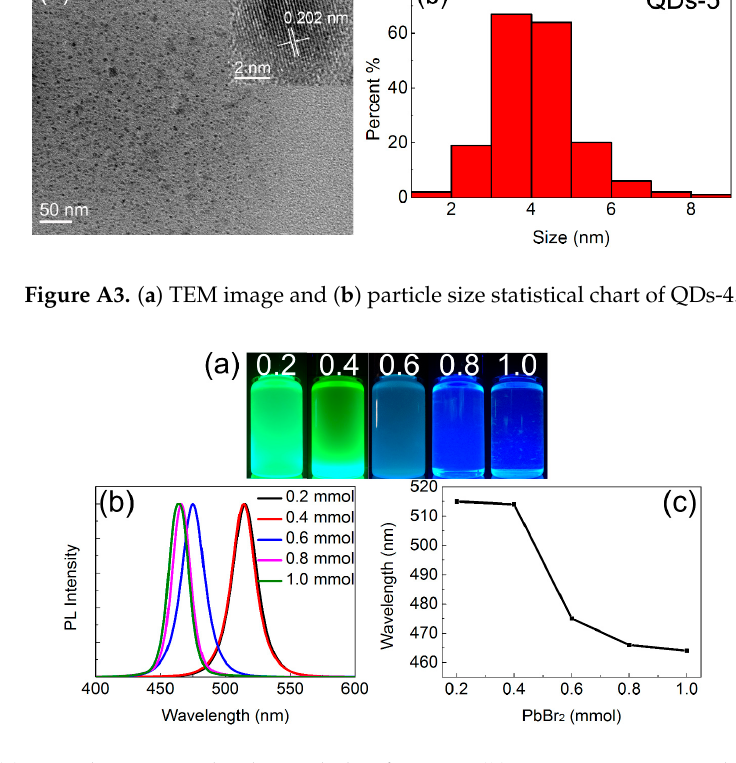
Figure A5. ( a ) Digital images under the UV light of 365 nm; ( b ) emission spectra; and ( c ) wavelength statistical chart of QDs-M with different velocity of precursor, where chloroform is used as nonpolar solvent.